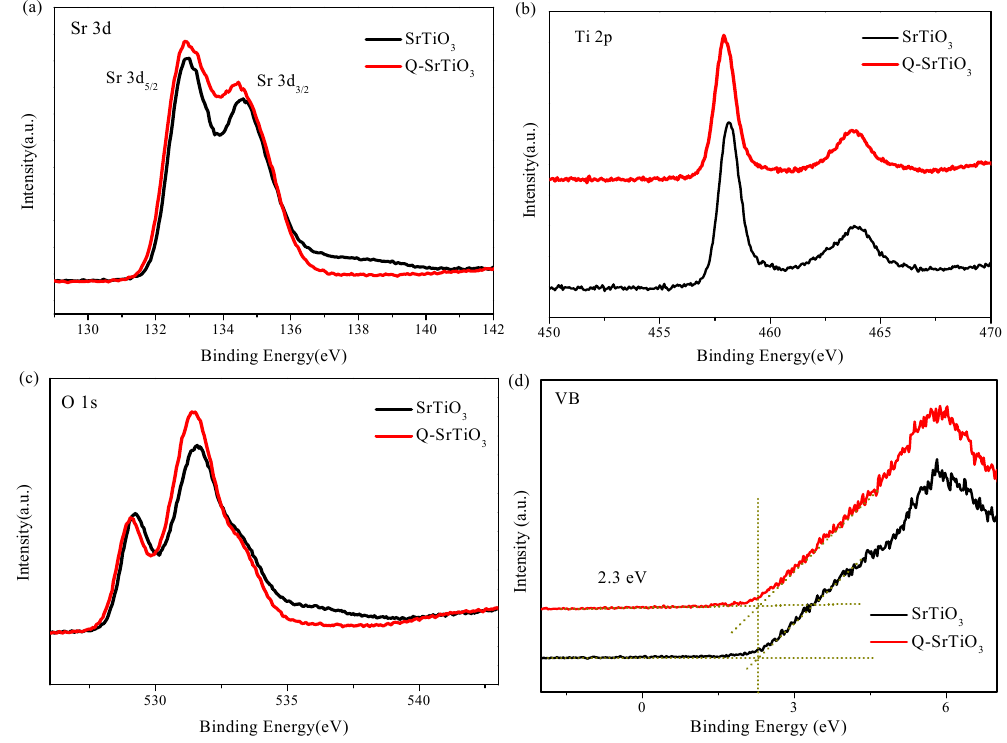
Figure 4. Sr 3d XPS spectra ( a ), Ti 2p XPS spectra ( b ), O1s Spectra ( c ), XPS valence band spectra of SrTiO 3 and Q-SrTiO 3 samples ( d ).